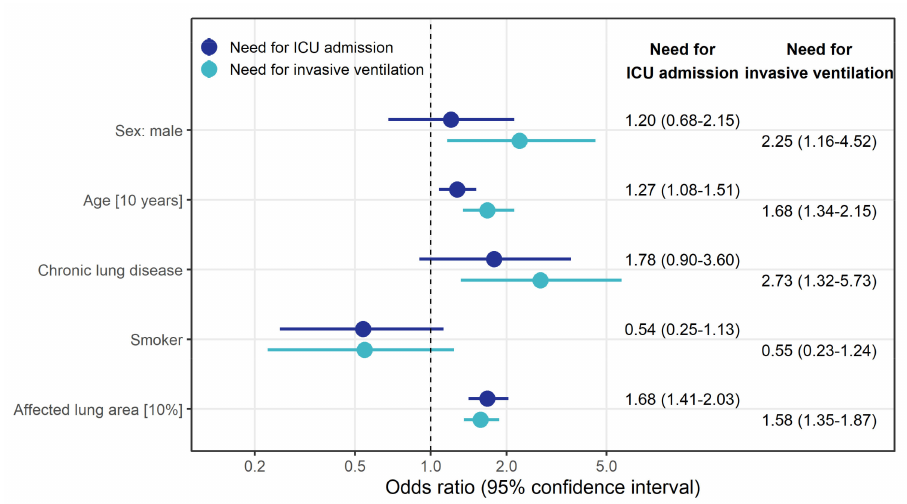
Figure 4. Odds ratio estimates along with 95% confidence intervals (CIs) derived from logistic regression model to identify factors associated with the risk for ICU admission (left column) and invasive ventilation (right column). The model included all variables